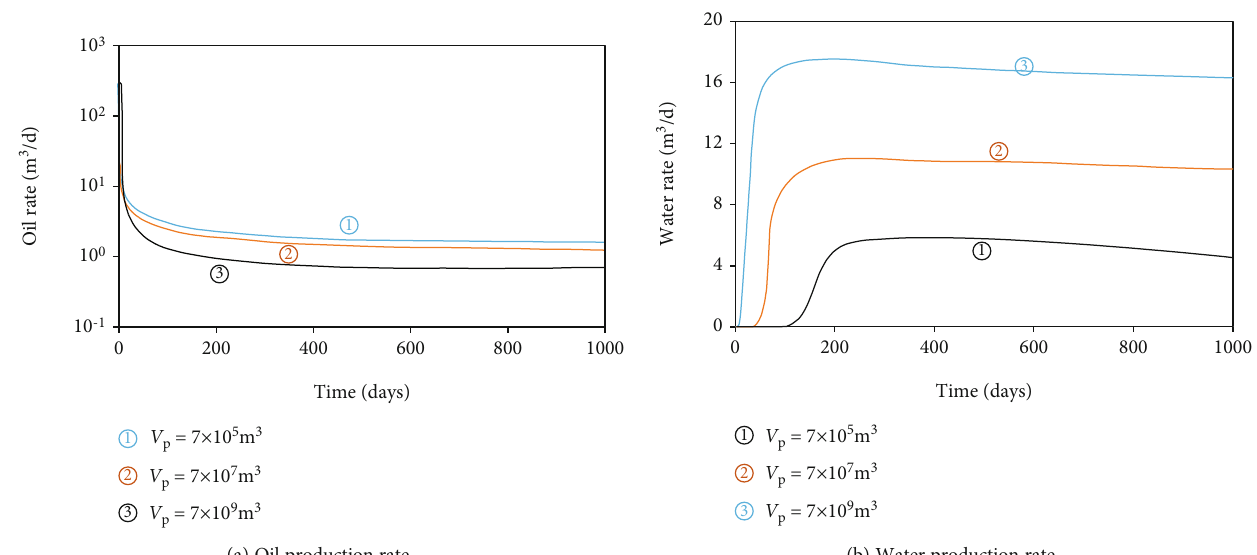
Figure 9: E ff ect of the inclination angle on oil and water production